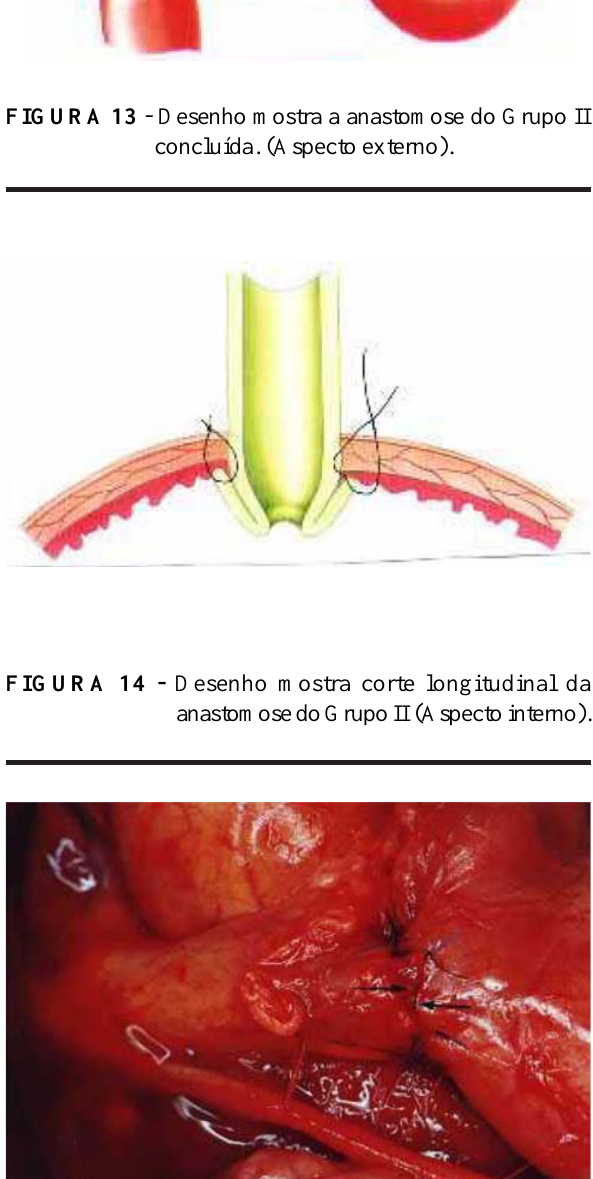
FIGURA 15 - Fotografia do ato operatório mostra o aspecto final da operação do Grupo II.